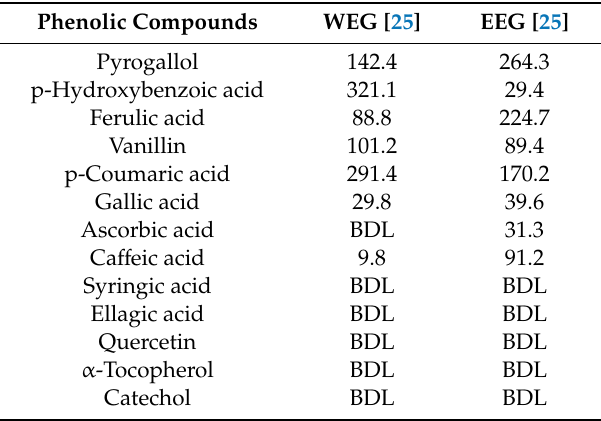
Table 3. Phenolic compounds detected in